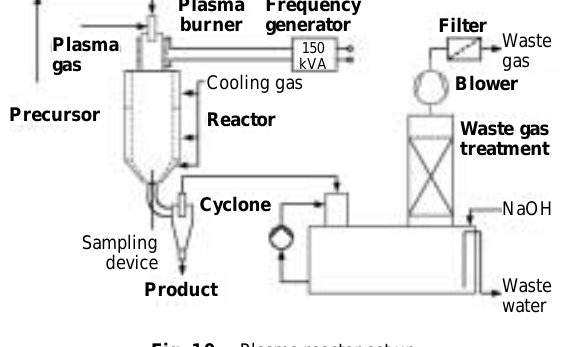
Fig. 10 Plasma reactor set-up.